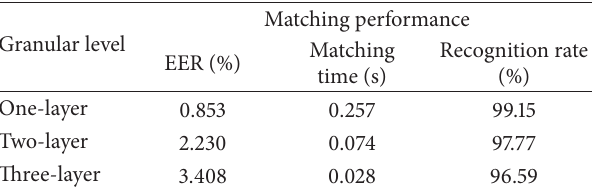
Figure 7: Comparisons between multimodal biometric systems. Table 1: Matching results of different levels FGs.